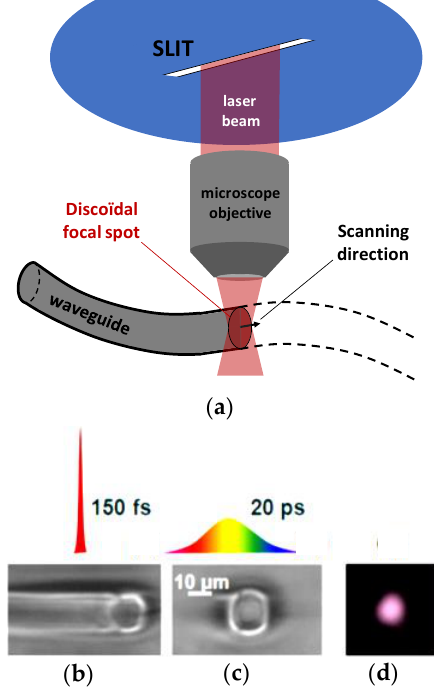
Figure 2. ( a ) Schematic of the beam slit-shaping technique applied to the transverse photo-inscription of buried waveguides; ( b ) Phase contrast images of the cross-section of a photo-inscribed trace in bulk Ge 15 As 15 S 70 glass with a 30 mW laser pulse at 100 kHz (slit aperture 100 µm, focusing objectif with NA = 0.42). As can be seen, irradiation with femtosecond pulses determines extended damage around the core; ( c ) Irradiation results with elongated linearly chirped pulses, a durations of 20 ps can limit the collateral damage and create symmetric core traces; ( d ) The near-field image of the guided mode at the exit of the waveguide, at 800 nm, is given for the latter